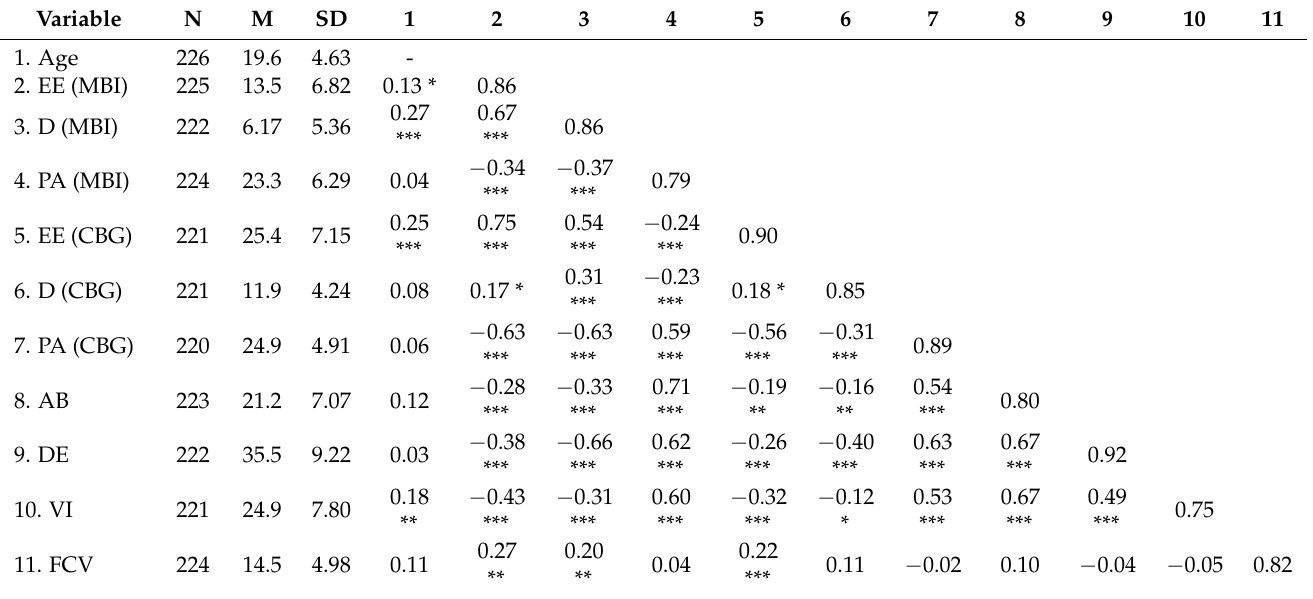
Table 2. Descriptive statistics and correlations for continuous variables in the second